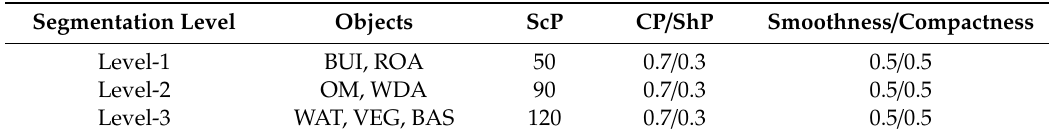
Table 2. Parametersutilizedinmulti-scalesegmentation(MSS).ScP:scaleparameter; CP:colorparameter;